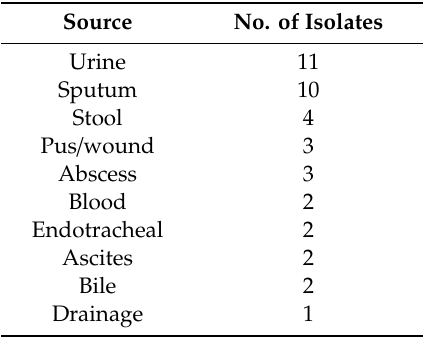
Table 1. Sources of the 40